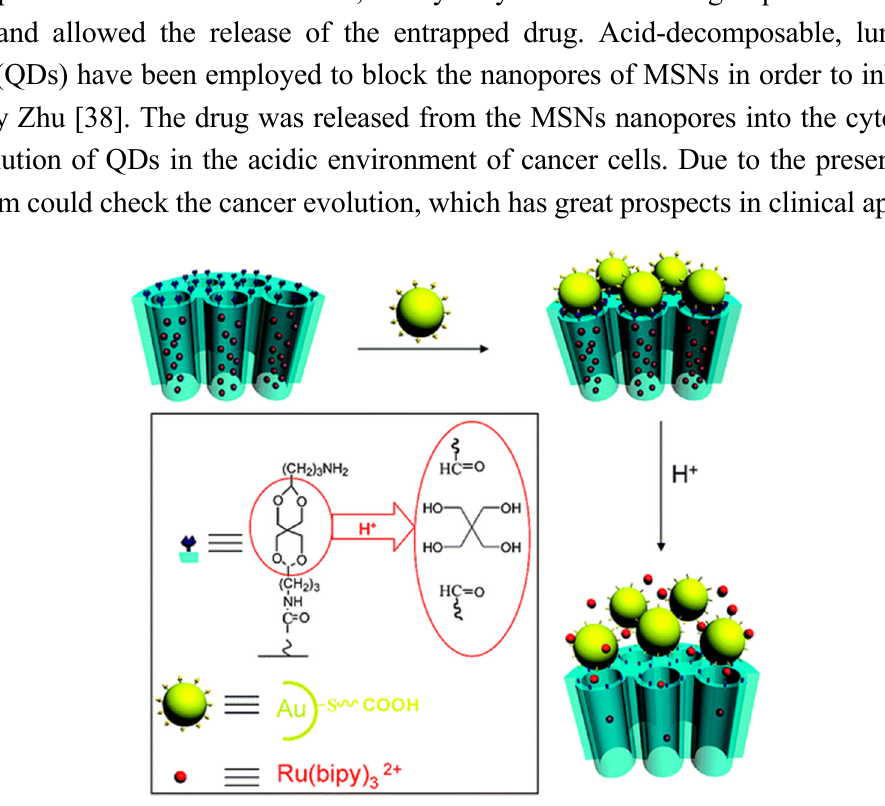
Figure 3. Schematic illustration of pH-responsive nanogated ensemble based on gold-capped MSNs through acid-labile acetal linker. Reproduced with permission from [37]. Copyright American Chemical Society,